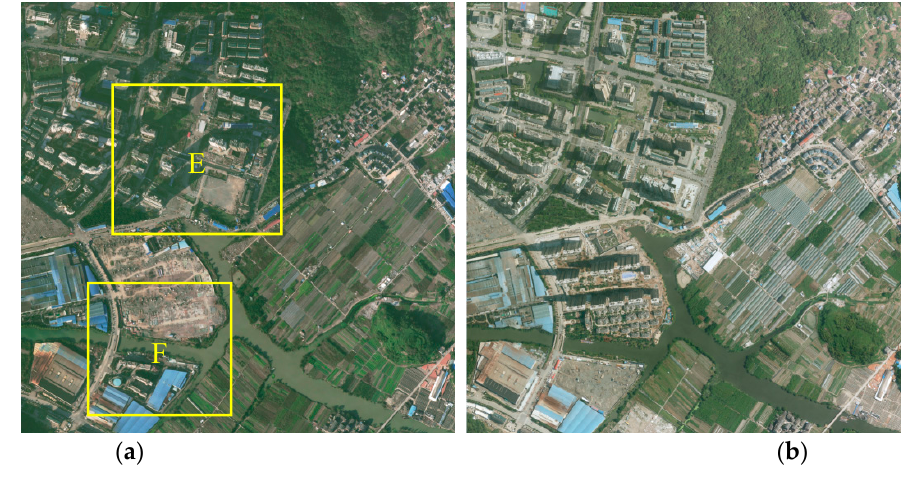
Figure 12. Overview of Dataset 2: aerial images at time ( a ) t 1 and ( b ) t 2 .